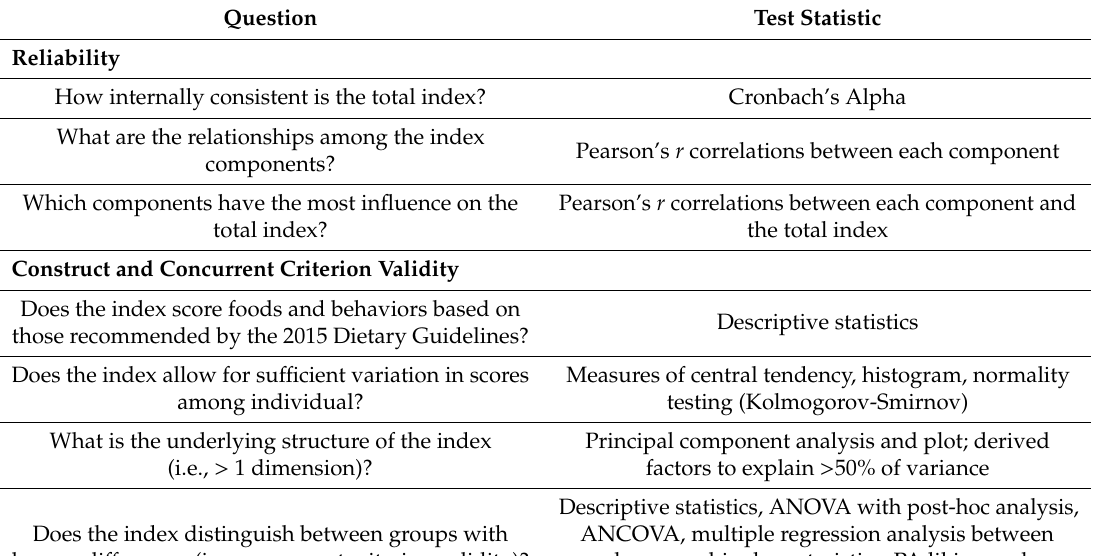
Table 2. Tests to assess the internal reliability and validity of the Healthy Behavior Index (HBI)